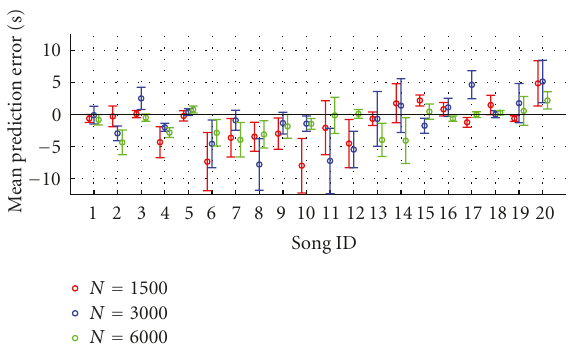
Figure 7: Number of particles N versus prediction